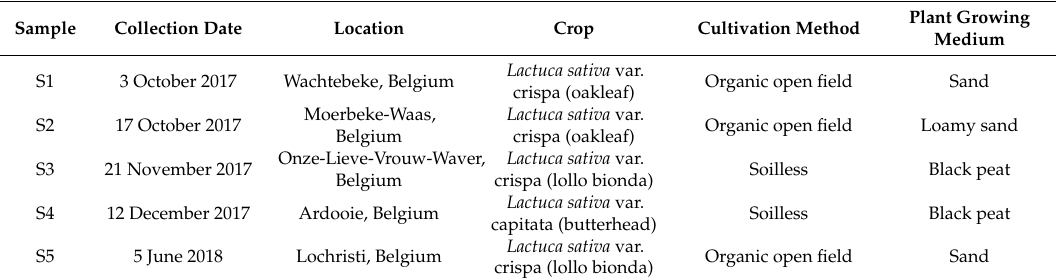
Table 1. Overview of Rhizosphere Sampling Locations.